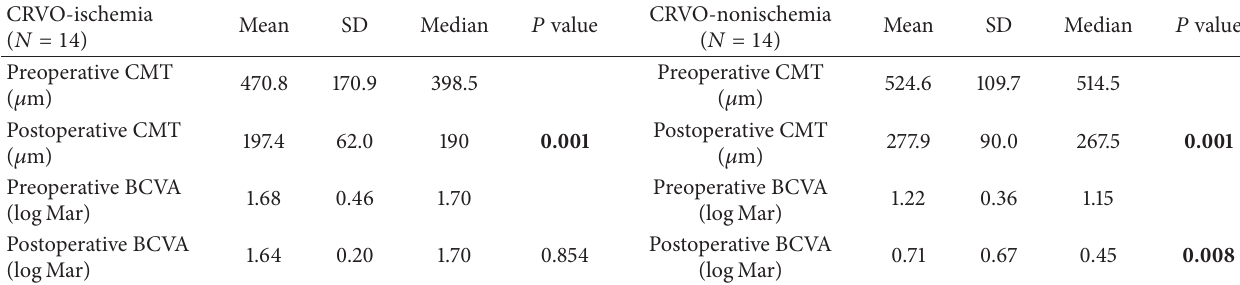
Table 3: Comparison of pre- and postoperative central macular thickness and best corrected visual acuity in log Mar in the ischemic and nonischemic subgroups.